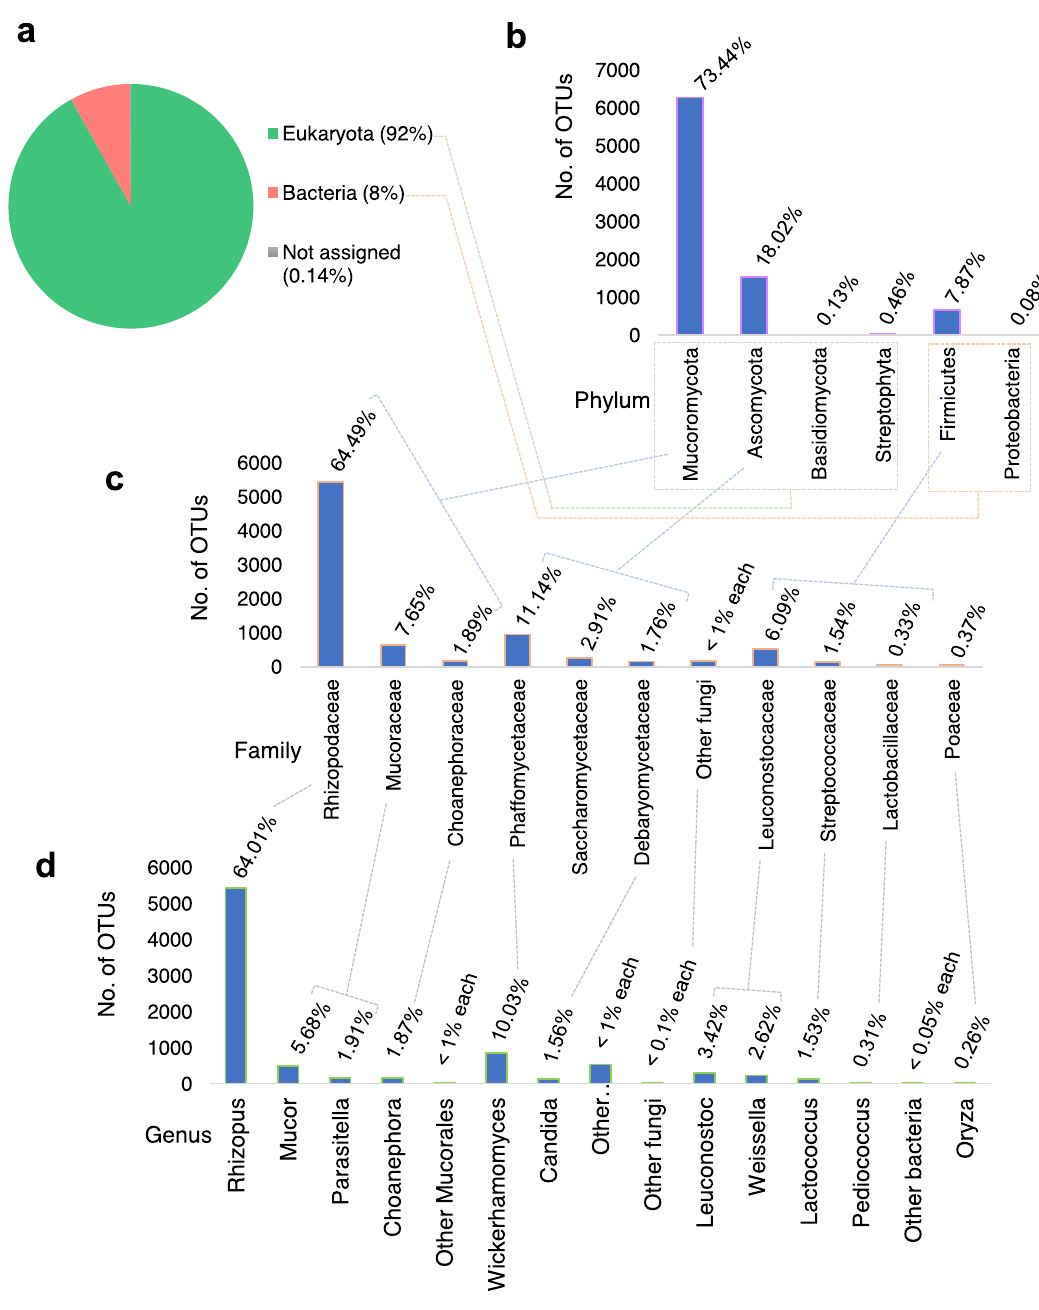
Figure 2. Estimation of community structure in the emao based on ribosomal protein sequence analysis. The ratio of molds, yeasts, and bacteria was 9:2:1. ( a) At domain level; ( b) at phylum level; ( c) at family level; ( d) at genus